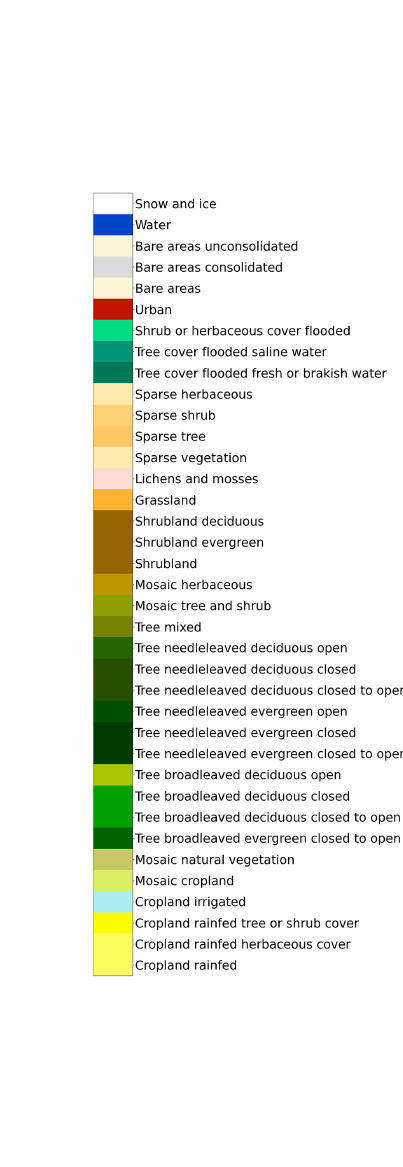
Figure C2. ESA-CCI segments with full ESA-CCI labelling for the satellite areas displayed in Figs. 7 and